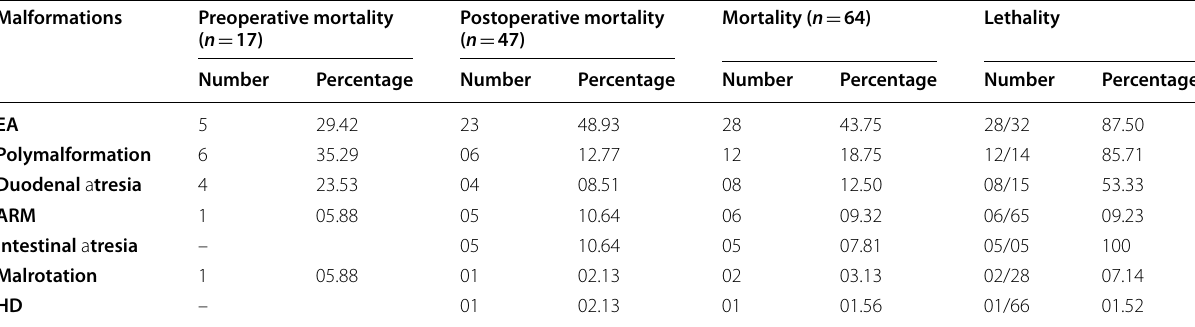
ARM Anorectal malformation, EA Esophageal atresia, HD Hirschsprüng’s disease